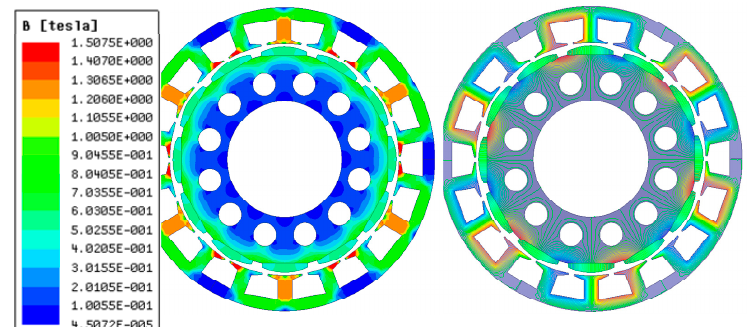
Figure 7. Magnetic cloud and line map of 3* three-phase PMSG.